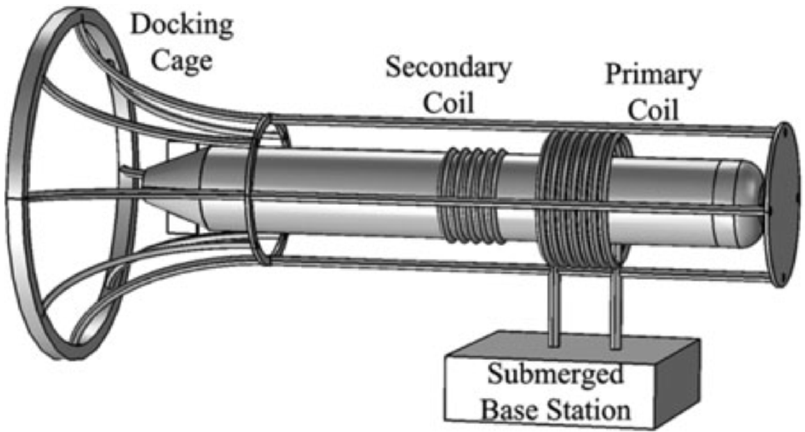
Figure 27. Concentric Circular Structure for AUVs [86].